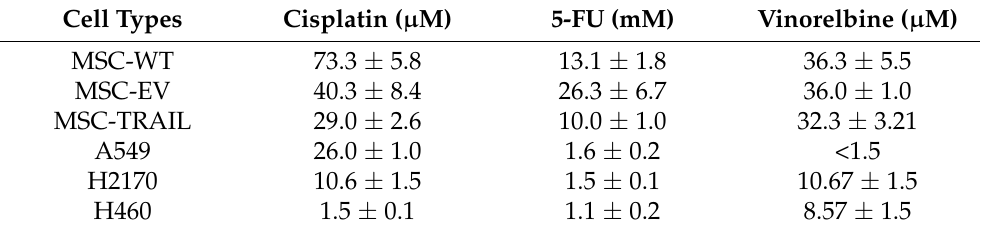
Table 1. The IC 50 values of all three chemotherapies in MSC variants and NSCLC cell